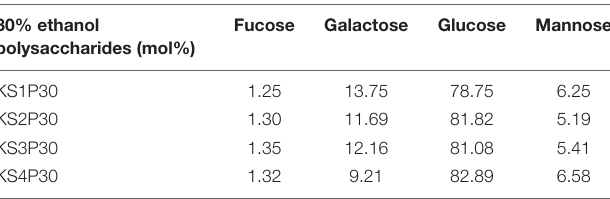
TABLE 2 | Monosaccharide composition of 30% ethanol precipitated polysaccharides obtained from L. edodes at different development stages. 30% ethanol polysaccharides